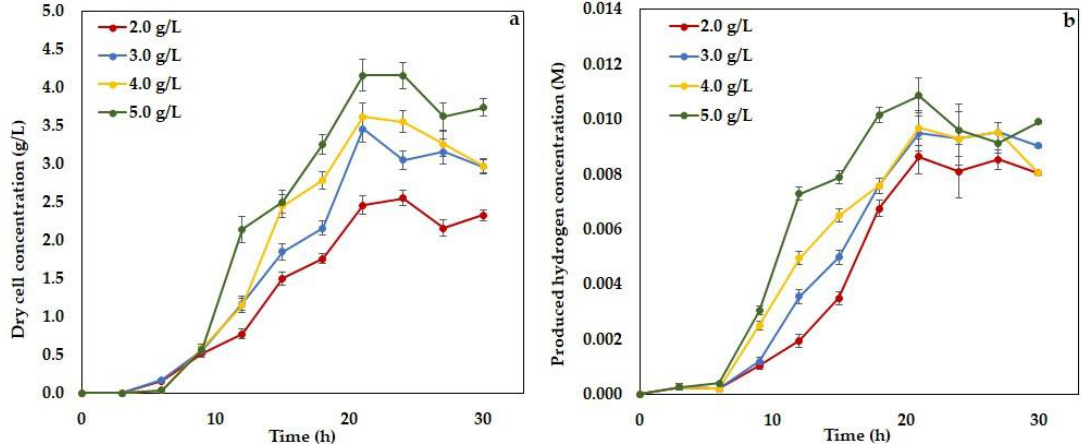
Figure 6. Experimental time histories of dry cell concentration ( a ) and hydrogen concentration ( b ) with initial 10% H 2 in reactor headspace at different substrate concentration.